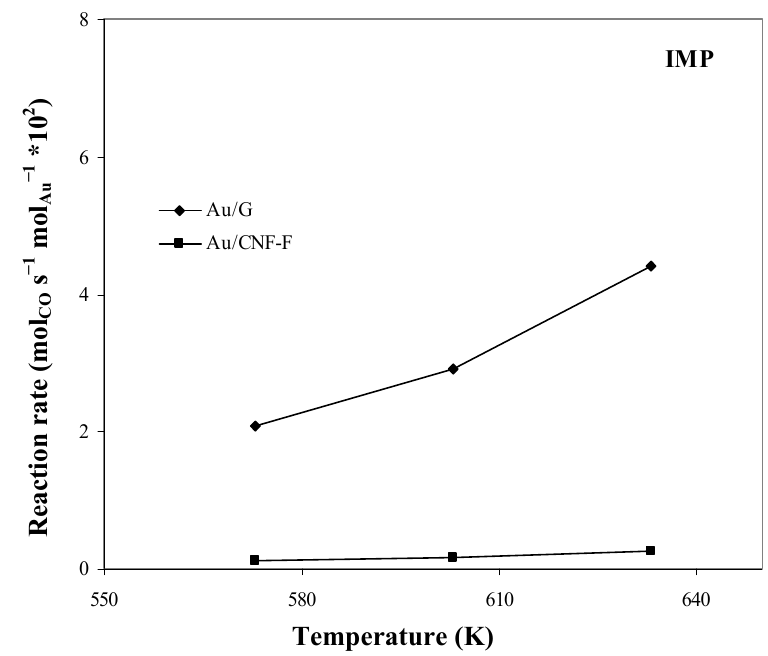
Figure 10. Influence of the Au introduction method and the nature of the support: Reaction rate versus temperature (steam-to CO molar equal to 2/1).